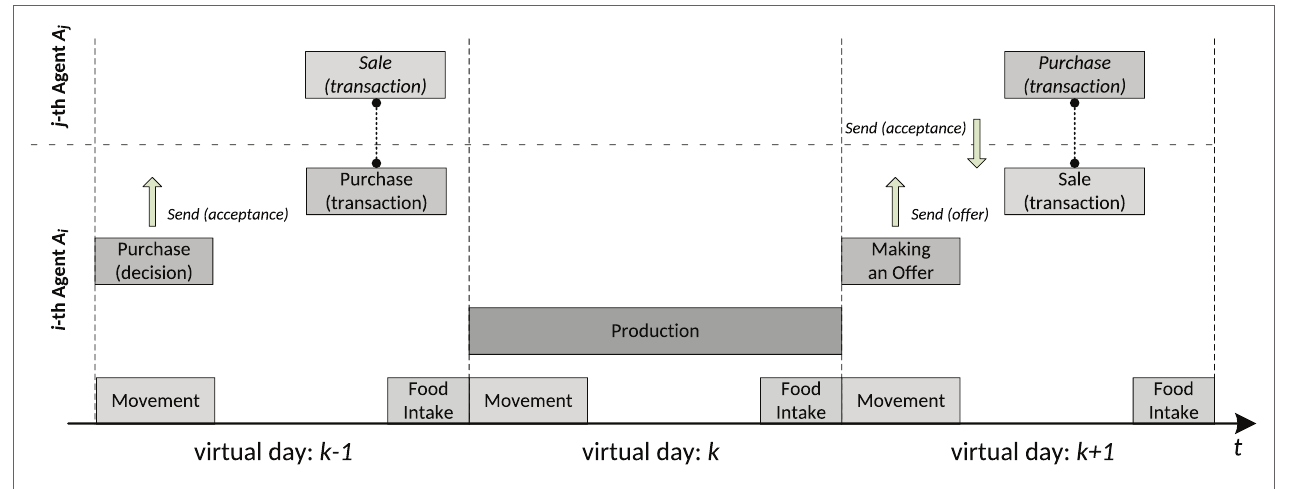
FigUre 7 | example of agent activities over time